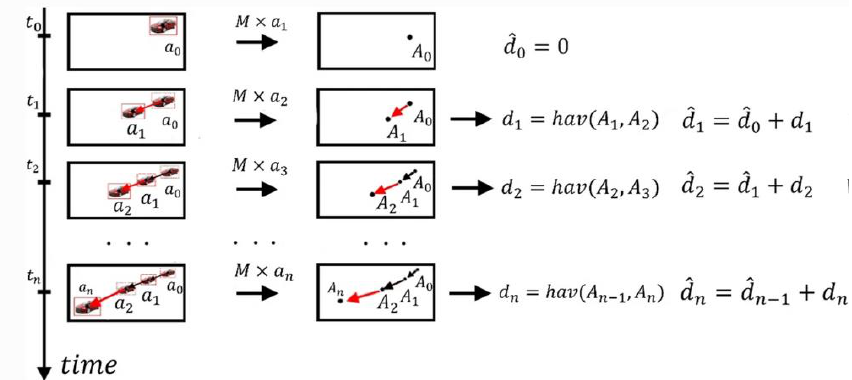
Figure 3. Matrix of perspective transformation to determine the time spent by the vehicle within the control zone, where a i is the coordinates of a specific vehicle; d i is the distance between two points; and t i is the time between frames.